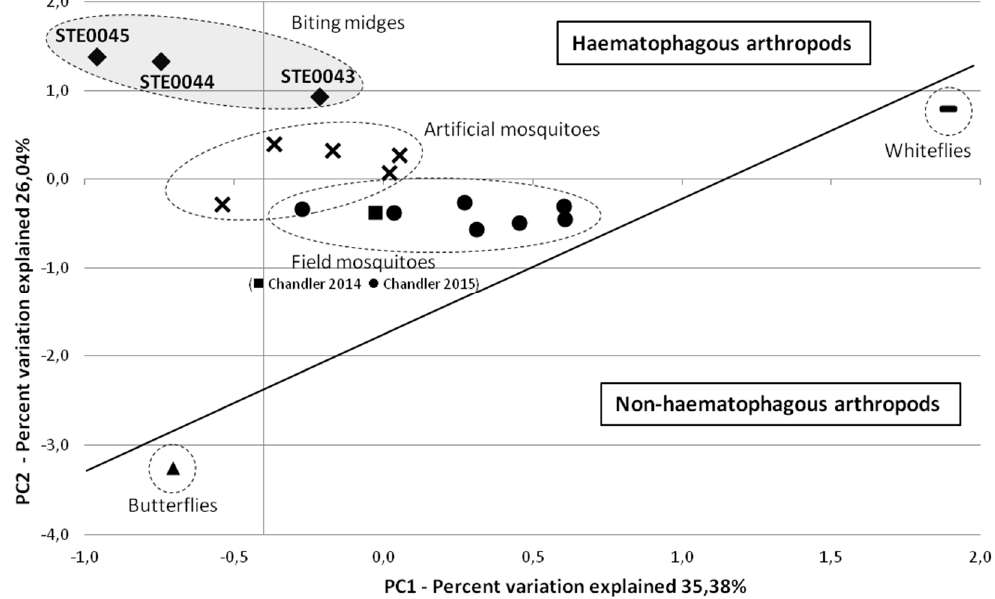
Figure 3. Comparison between viromes of biting midges with available arthropod RNA metagenomes based on a taxonomic classification of reads. Principal component analysis (PCA) was used to compare data in MG ‐ RAST server [21] with a maximum E ‐ value of 10 − 5 , a minimum identity of 60%, and a minimum alignment length of 15 amino ‐ acids for protein and 15 bp for RNA databases. Data were normalised to values between 0 and 1 and distances were measured using the Bray ‐ Curtis distance matrix.